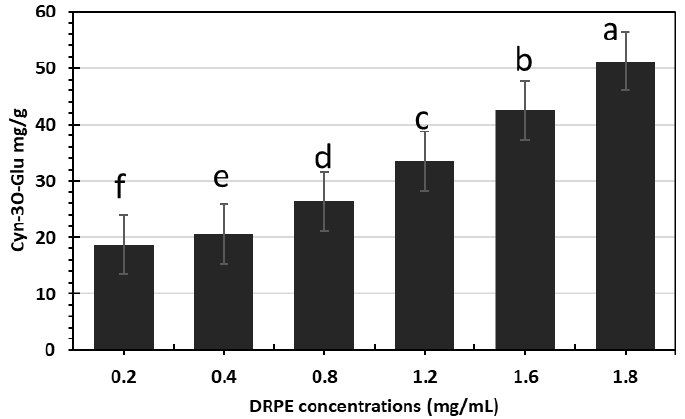
Figure 2. Anthocyanin compounds of DRPE are expressed as cyanidin-3-O-glu equivalents. Lower- case letters above the columns indicate significant differences at a 5% probability level.